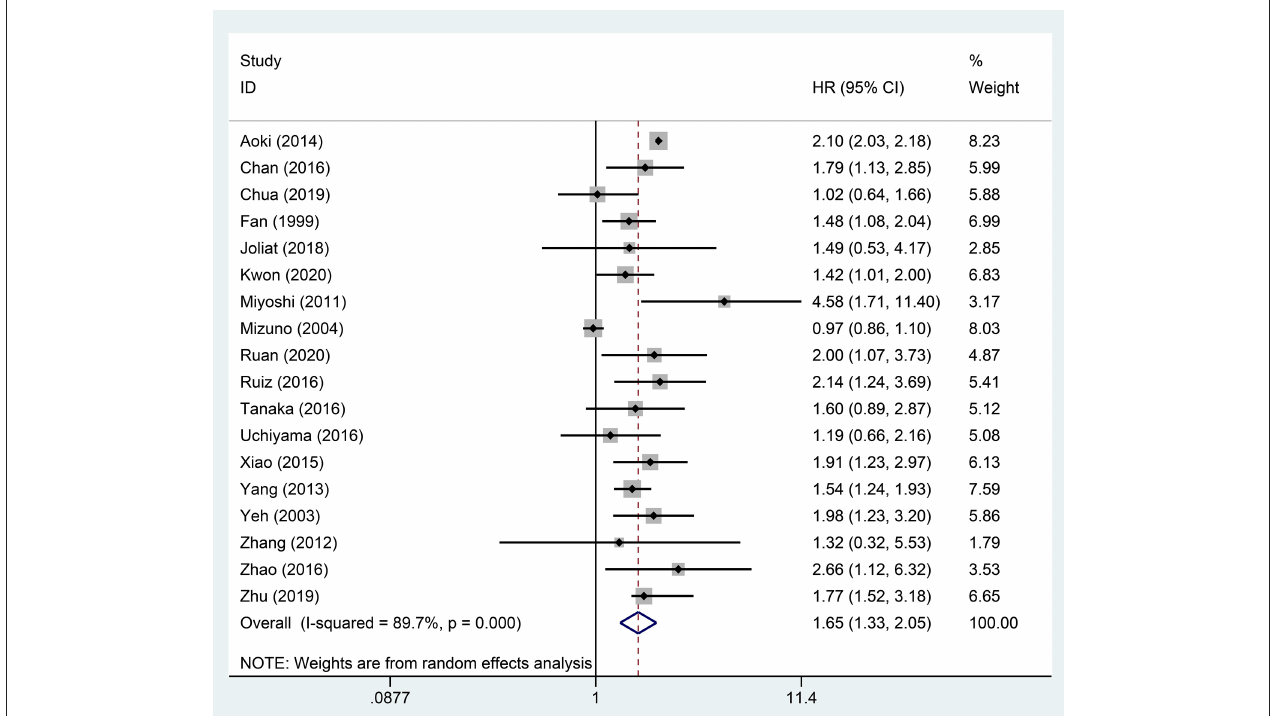
FIGURE 2 | Forest plot of OS of ruptured hepatocellular carcinoma (HCC) patients after hepatectomy ( P < 0.001).